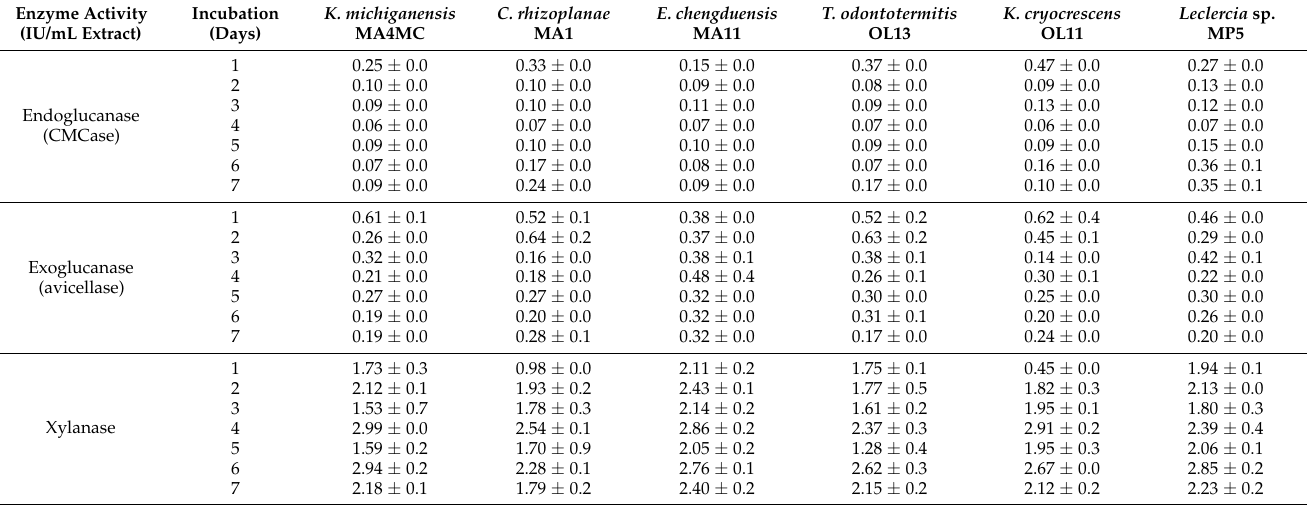
Table 3. Profile of the enzyme activities of potential isolates during the growth on rice